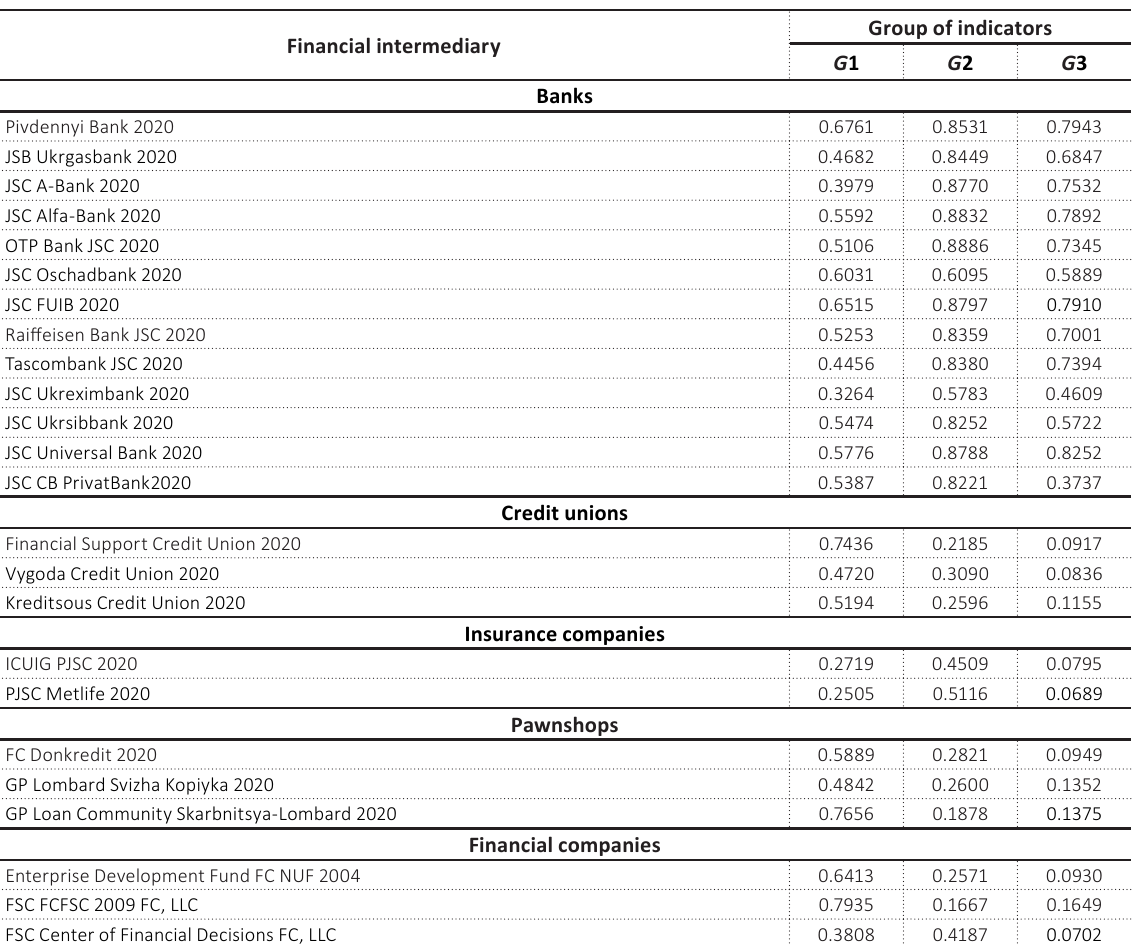
Table 5. Synthesis function G for each group of indicators as of January 1, 2021 Financial